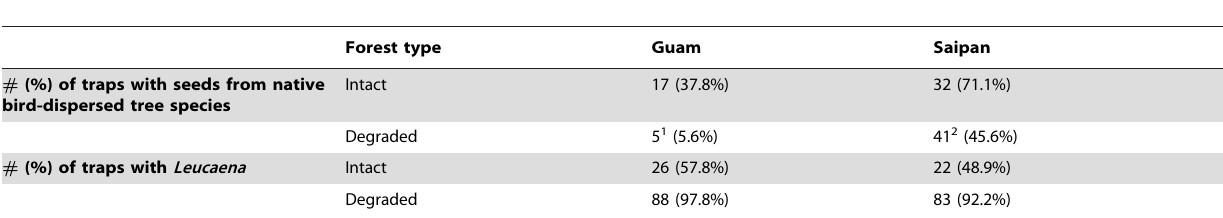
Table 2. Summary of seed trap contents on each island, and in each forest